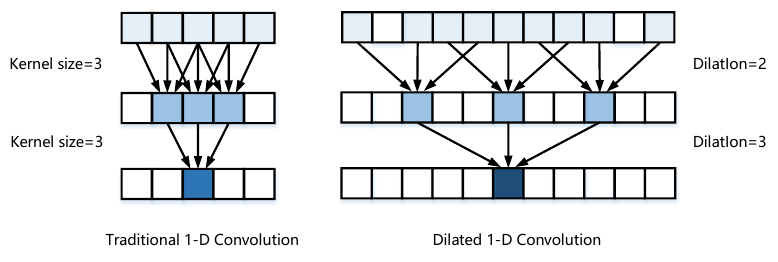
Figure 2. Traditional convolutional neural networks vs. dilated convolutional neural